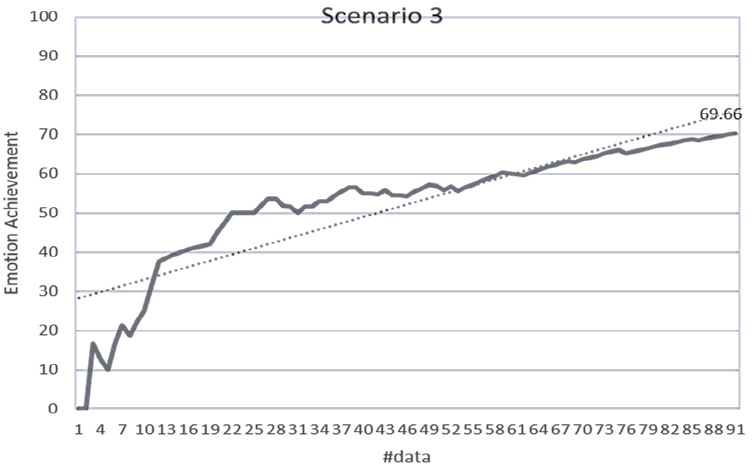
Figure 17. Emotion achievement for scenario 3. The thick line shows the increase of the achievement according to the number of sensory changes, and the dotted line shows the trend of this increase.